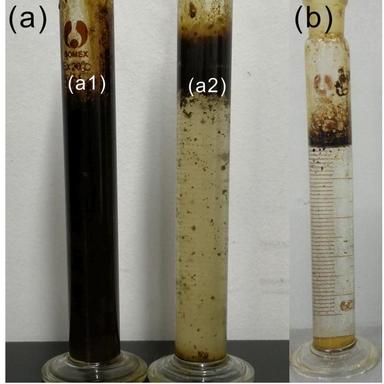
(a) Bottle test of demulsification driven by Nanosheets synthesized from attapulgite (a2) and water (a1) as reference. (b) The separated water after demulsification for 4 h.